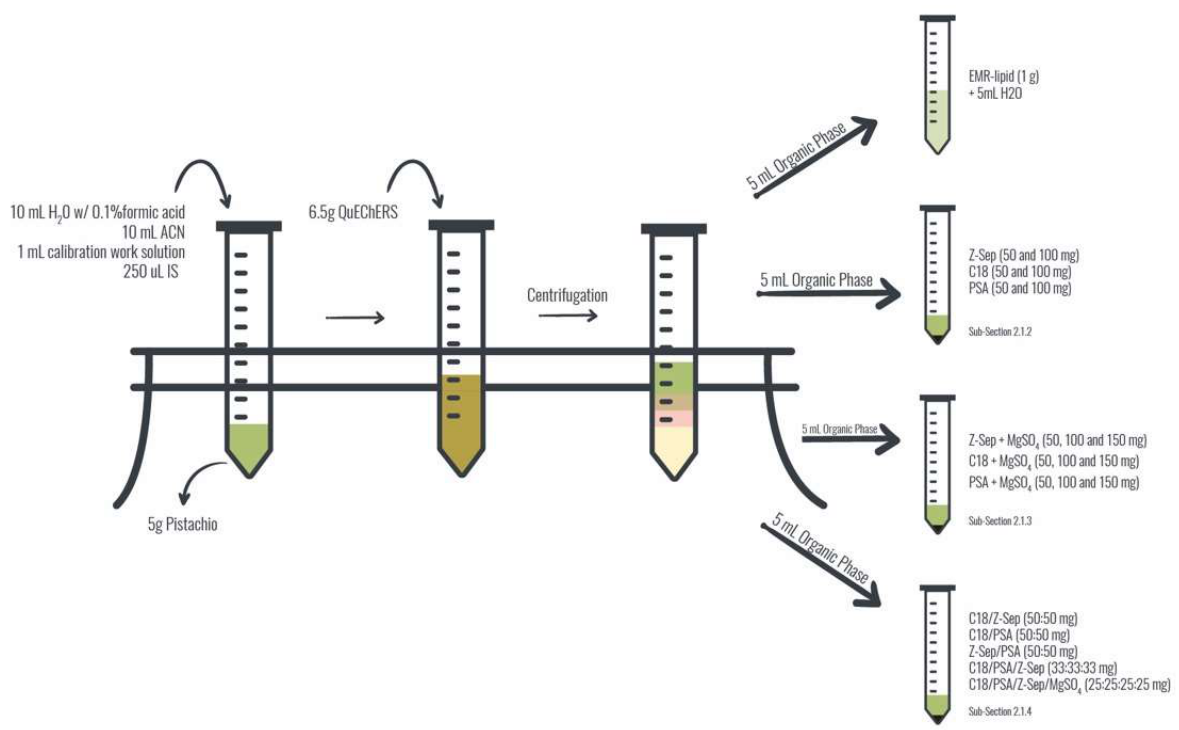
Figure 2. Diagram of different dispersive solid-phase extraction (d-SPE) clean-up procedure experiments.